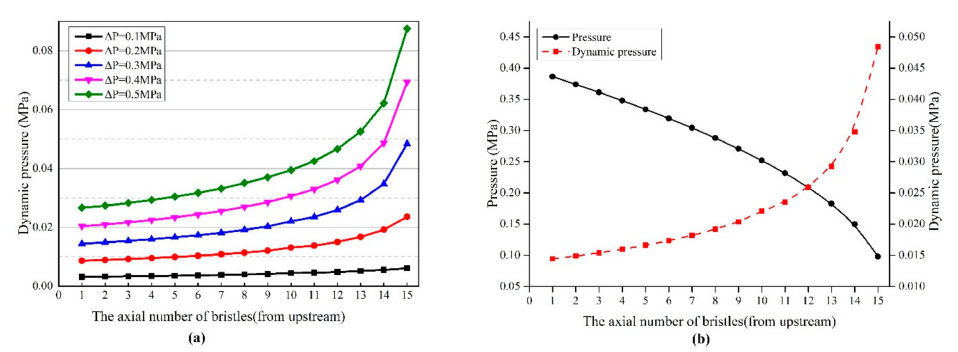
Figure 6. The dynamics pressure distribution of S D /d = 1.10 case. ( a ) The effect of differential pressure; ( b ) the relationship between pressure and dynamic pressure at ∆ P = 0.3